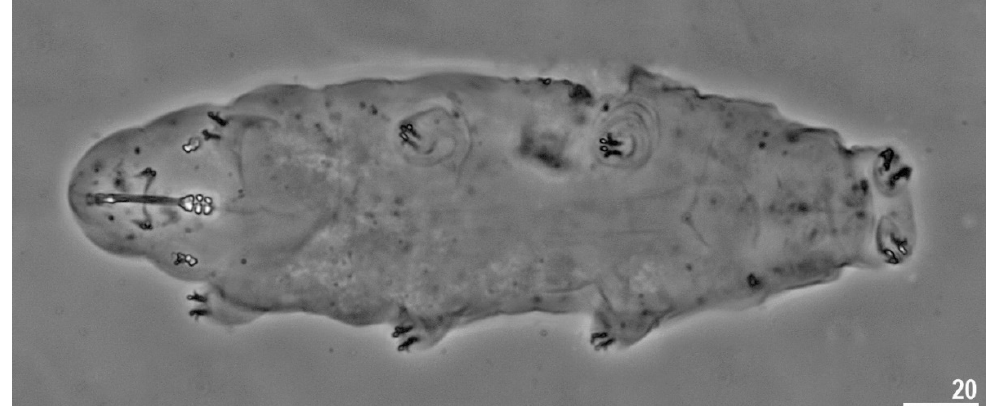
Figure 1. Minibiotus intermedius : adult specimen, dorso-ventral projection (neotype, PCM). Scale bar in μ m.